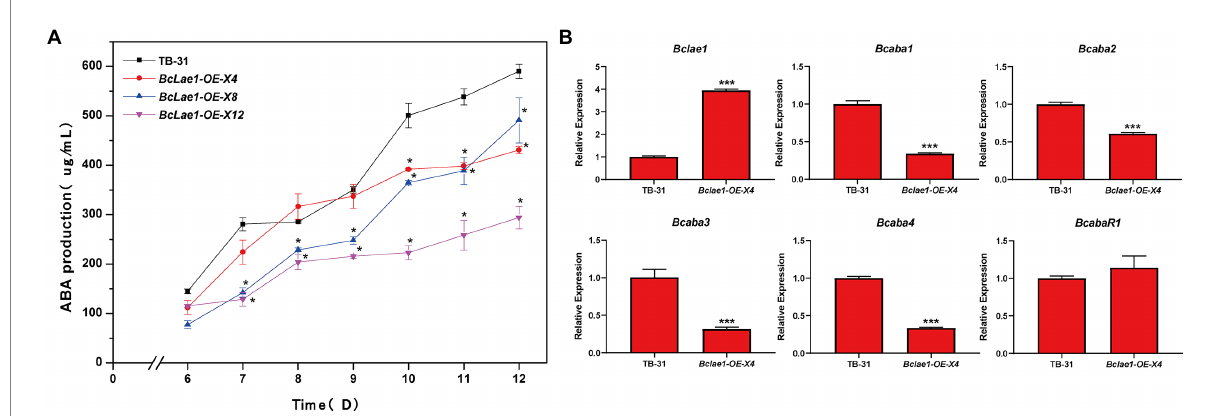
FIGURE 5 Overexpression of Bclae1 reduced ABA synthesis in B. cinerea TB-31. (A) The TB-31 and 3 randomly selected Bclae1 -OE mutants ( Bclae1 -OE-X4, Bclae1 -OE-X8, Bclae1 -OE-X12) were grown on PDA. Samples for the quantitative determination of ABA production were collected at 6–12 days. The error bars indicate the standard errors of the mean for three replicate cultures ( n = 3). Asterisks indicate significant differences in ABA production between selected mutants and TB-31 ( p < 0.05). (B) RT-qPCR examining the transcriptional levels of ABA gene cluster, BcabaR1 and Bclae1 in Bclae1 -OE-X4 and TB-31. The relative transcriptional levels of selected genes were obtained after normalization to the constitutive tubulin reference gene (BC1G_05600) at 6 days. The relative values for selected genes transcription at 6 days in TB-31 were arbitrarily assigned as 100%. Shown are means and SEM, n = 3 independent biological replicates. *** p < 0.001 versus the same genes of the TB-31